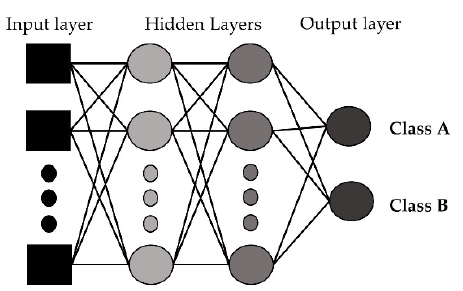
Figure 7. Artificial neural network with input, hidden, and output